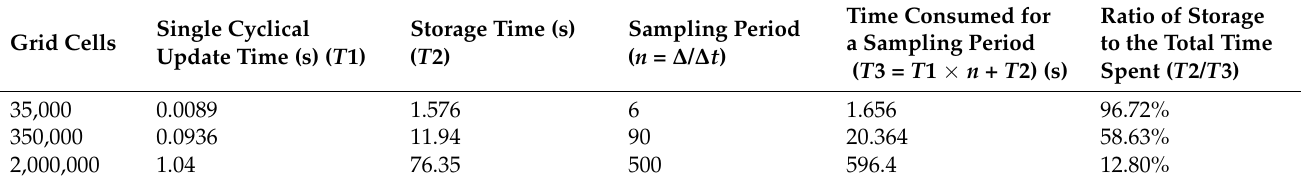
Table 1. Serial program performance analysis table.